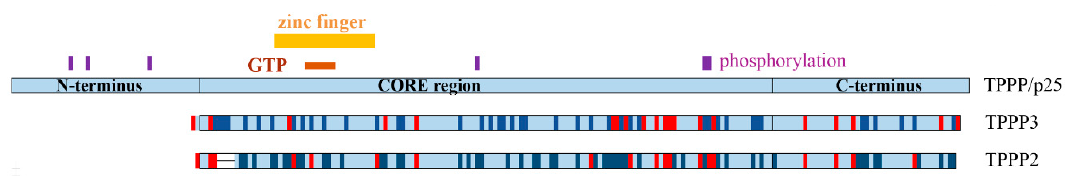
Figure 2. Scheme of the human TPPP/p25, TPPP3, and TPPP2. Similar and different residues are indicated by dark blue and red, respectively. The zinc finger motif, a consensus GTP-binding segment and phosphorylation sites on TPPP/p25 are also indicated.